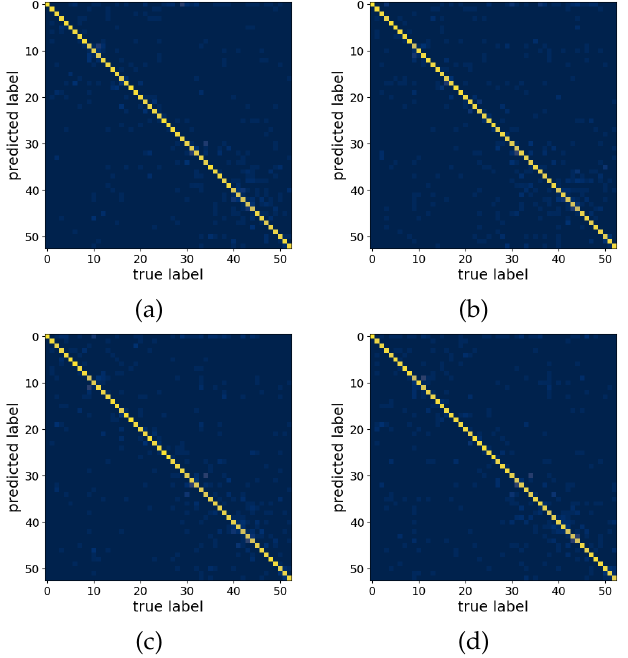
Figure 3. Confusion matrices for each of the models. ( a ) AoT300, ( b ) Att300, ( c ) AoT2500, and ( d ) Att2500.